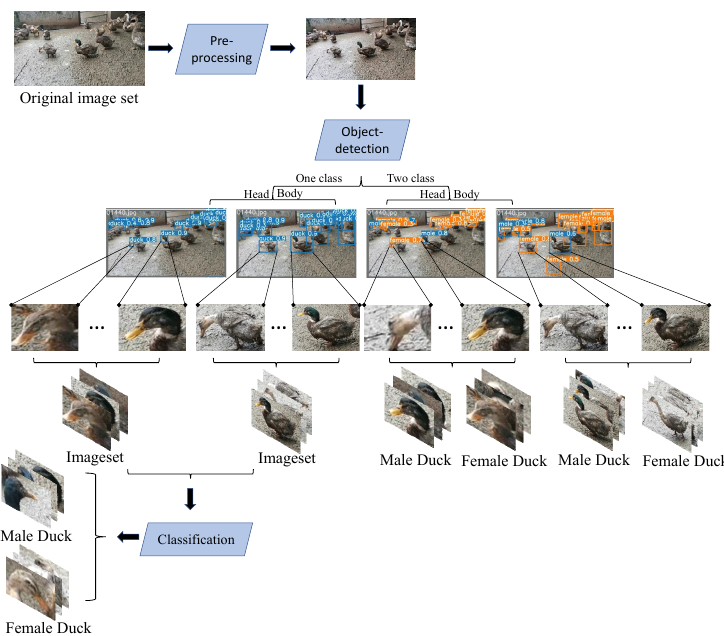
Figure 5. The general flow of the four schemes. The original image is pre-processed and fed into the target-detection network. When the image contains only one label, the target detection network only detects the duck category and then extracts the head and body of the duck from the completed image, and sends them to the classification network, respectively, to complete the recognition task.